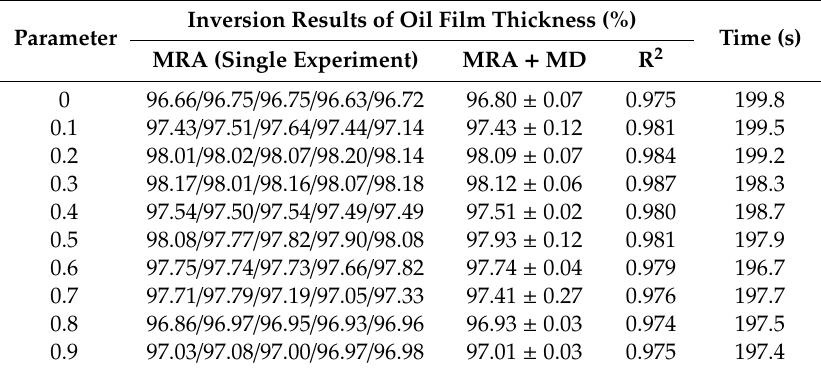
Table 7. Inversion results for various values of normalized cut-off frequency.